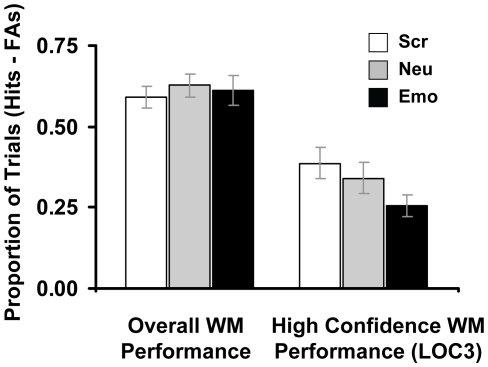
The detrimental effect of transient anxiety-inducing distraction on WM performances was reflected in responses with the highest level of confidence (LOC3).A two-way ANOVA on corrected recognition scores (% Hits – % FAs) yielded a significant level of confidence (LOC1, LOC2, LOC3) x distracter type (emotional, neutral, scrambled) interaction (F [4], [60]  = 8.57; p<0.00002), and post-hoc analyses showed that the emotional distraction had an impairing effect only on LOC3, with the emotional distracters being associated with lower level of performance compared to both neutral (p<0.02) and scrambled distracters (p<0.0005). Emo = Emotional Distracter; Neu  =  Neutral Distracters; Scr  =  Scrambled Distracters; FAs  =  False Alarms; WM  =  Working Memory. Error bars represent standard errors.